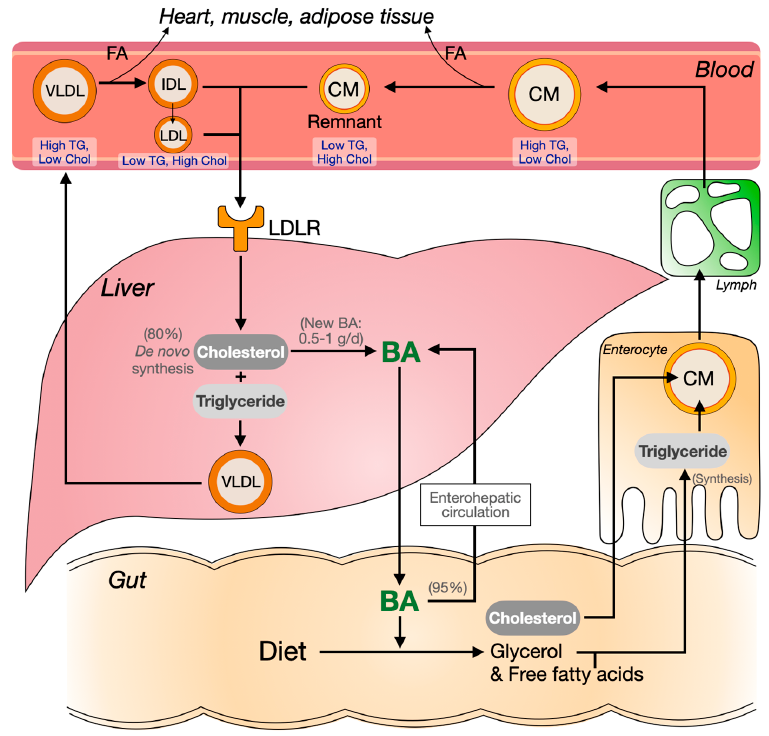
Figure 3. Lipid and lipoprotein metabolism. This figure gives a simplified impression of the metabolism of apoB-containing lipoproteins, which can be characterized by exogenous and endogenous pathways. Exogenous pathway: Dietary cholesterol and fatty acids (FA) are, with the help of bile acids, made available for uptake by epithelial cells of the small intestine. Here, these lipids are packaged in chylomicrons (CM), which are subsequently secreted into the lymph from where they reach the blood circulation via the thoracic duct. In the vasculature of peripheral tissues such as the heart, skeletal muscle and adipose tissue, lipoprotein lipase (LPL) catalyzes the lipolysis of triglycerides in CM, which allows for the uptake of FA by parenchymal cells. The resulting smaller so-called CM remnant particles are subsequently taken up by lipoprotein receptors such as LDLR (low-density lipoprotein receptor). Endogenous pathway: Dependent on the metabolic conditions, the liver can synthesize very-low-density lipoproteins (VLDL) to maintain overall lipid and energy homeostasis. After secretion into the systemic blood circulation, VLDL undergo the same metabolization as described for CM, which, in this case, renders smaller intermediate-density lipoproteins (IDL) and low-density lipoproteins (LDL) that are primarily taken up by the liver. The small intestine and liver finally also secrete the much smaller high-density lipoproteins (HDL), which carry apoA-I as major apolipoprotein. HDL only carry very small amounts of triglycerides compared to chylomicrons and VLDL and are instead rich in cholesteryl esters. HDL does not serve major metabolic functions but HDL-C